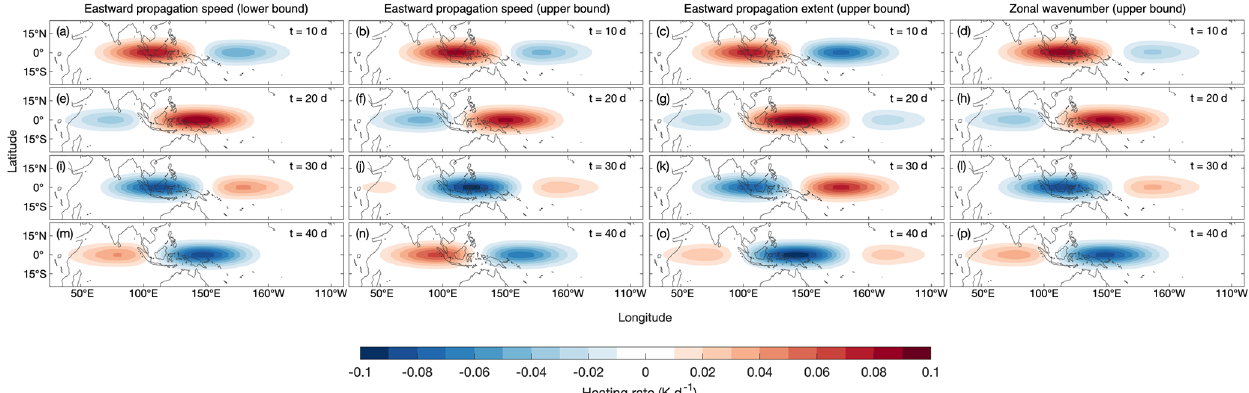
Figure A1. As in Fig. 1 but for the perturbed MJO cases for (a, e, i, m) the lower bound of the propagation speed experiment, (b, f, j, n) the upper bound of the propagation speed experiment, (c, g, k, o) the upper bound of the increased eastward propagation extent experiment, and (d, h, l, p) the upper bound of the perturbed wavenumber experiment.